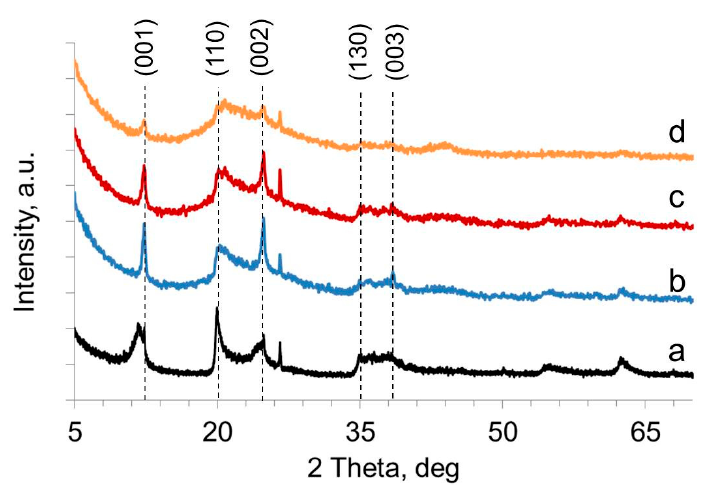
Figure 2. X-ray di ff raction (XRD) patterns for the HNT ( a ), HNT@Ru-1 ( b ), HNT@Ru-2 ( c ), and Figure 2. X-ray diffraction (XRD) patterns for the HNT ( a ), HNT@Ru-1 ( b ), HNT@Ru-2 ( c ), and HNT@Ru-3 ( d HNT@Ru-3 ( d ).